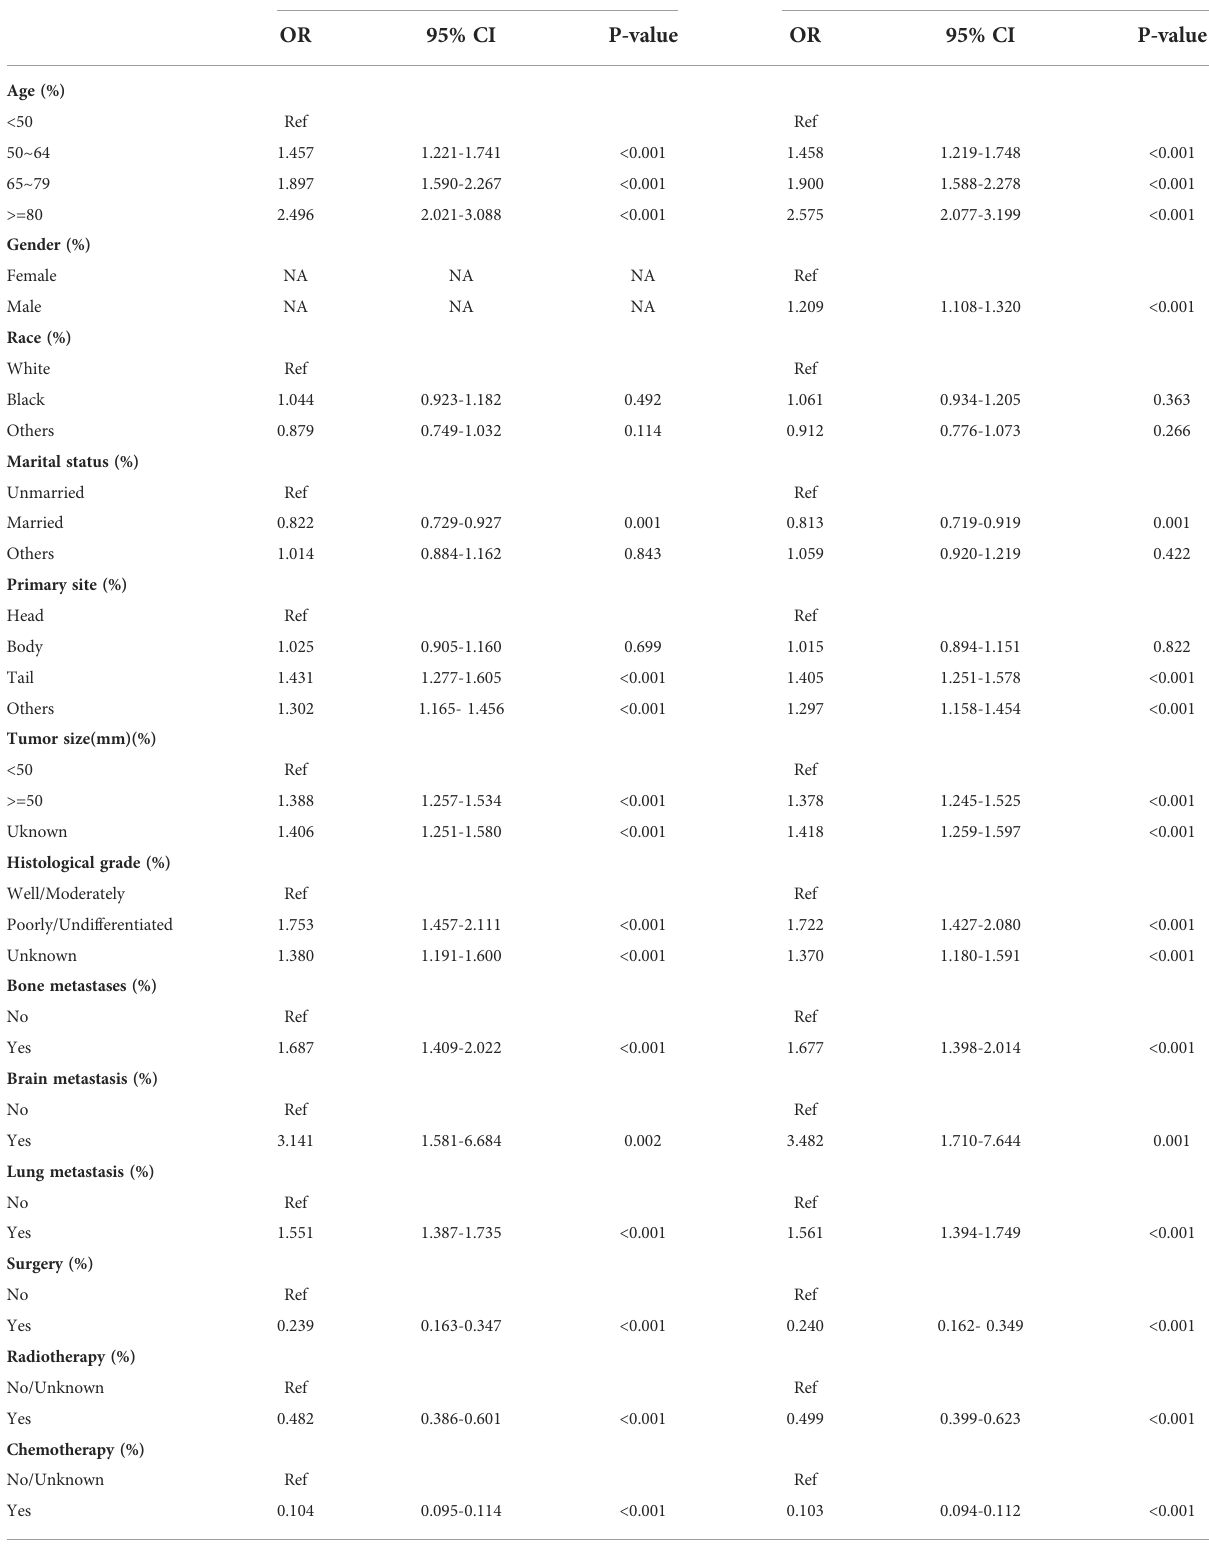
TABLE 4 The multivariable logistic regression analysis of all-cause and cancer-speci fi c early death in PCLM